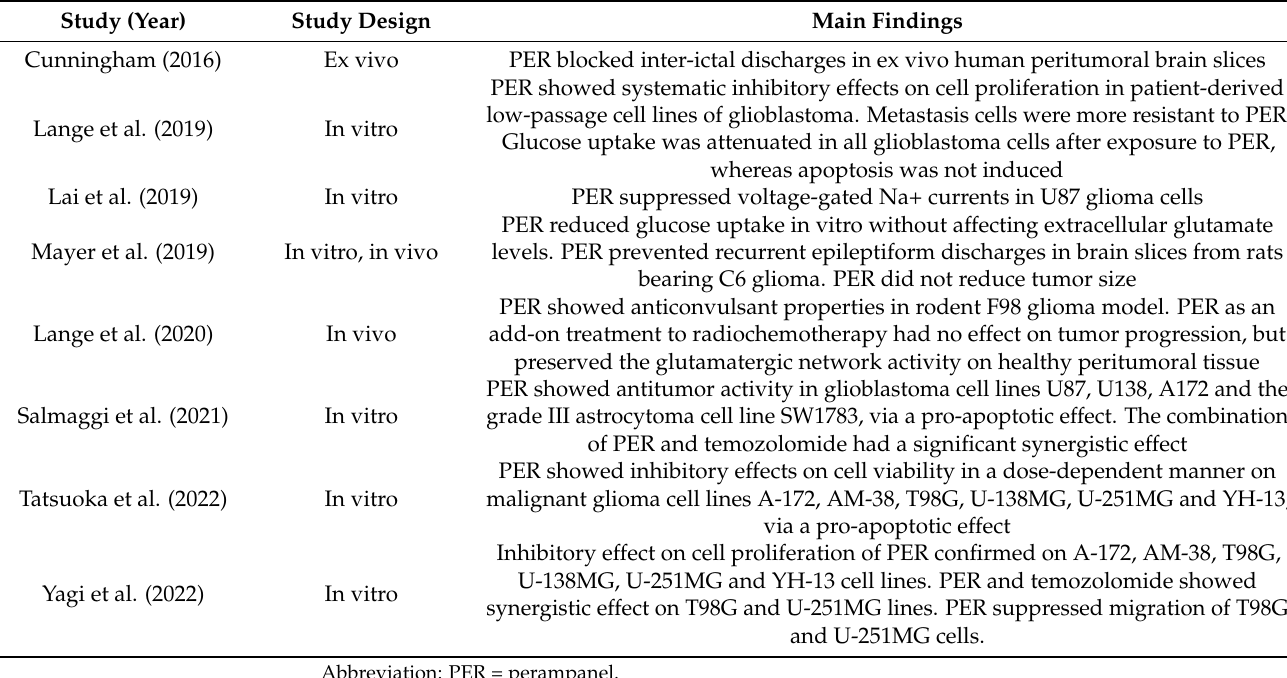
Table 1. Main characteristics and findings of pre-clinical